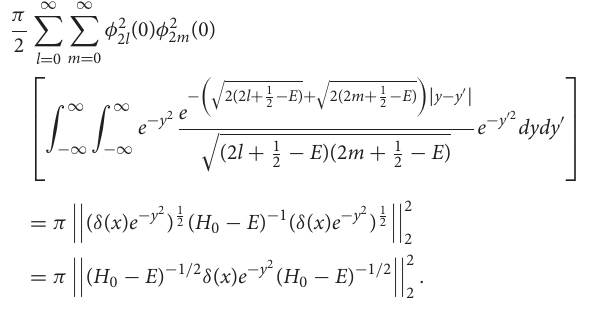
On the other hand, for small values of λ we can prove that